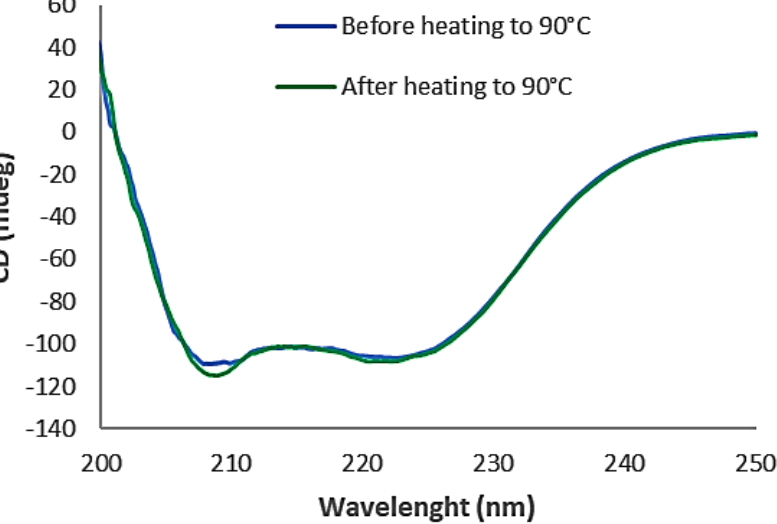
Figure 3. The CD (in mdeg) is plotted as a function of wavelength. Folding seems to be reversible after heating the molecules to 90 °C.